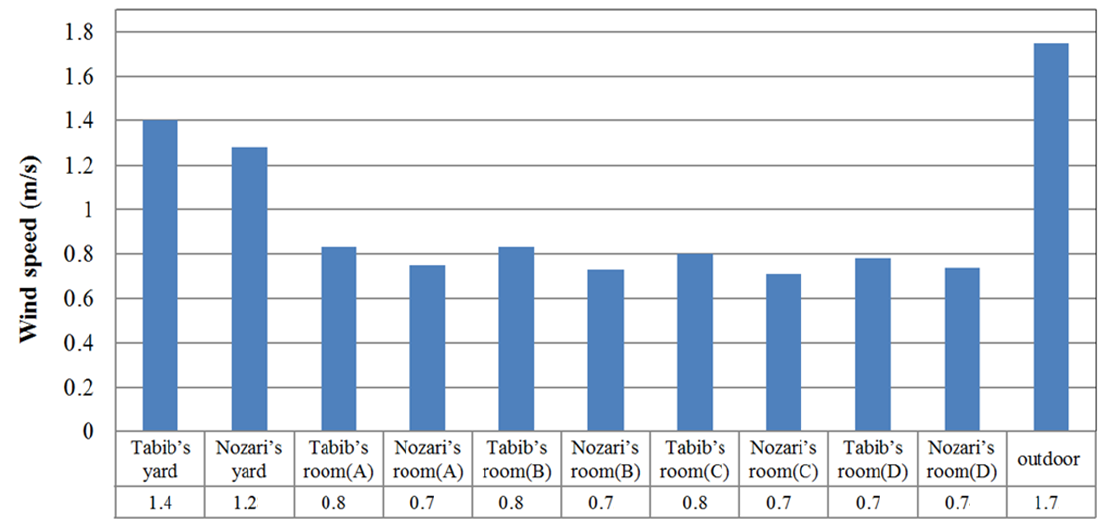
Figure 18. Average wind speed of spaces during test days effectively (August 30 and, September 1, 4, 16, 23, 27, and 30, 2016).